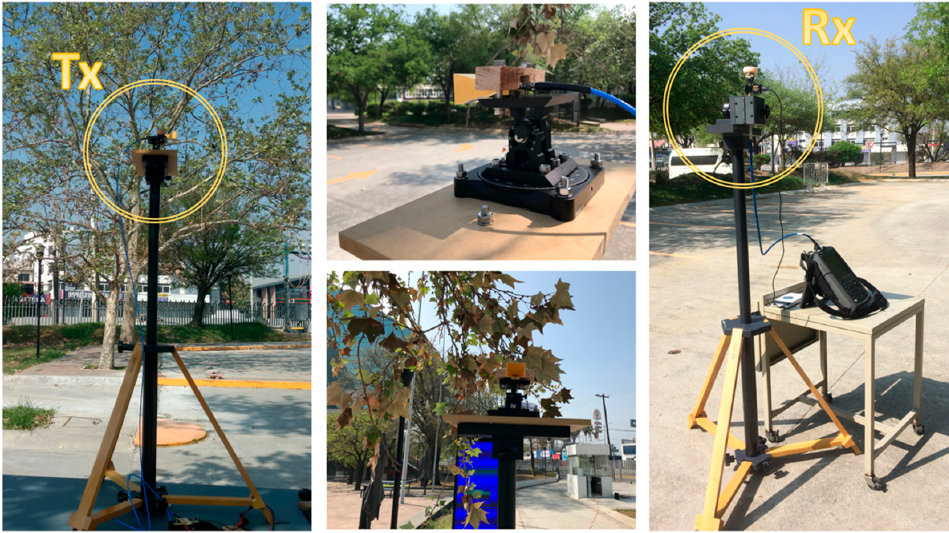
Figure 4. Transmitter and receiver experimental setup in the actual outdoor parking during the measurement campaign.